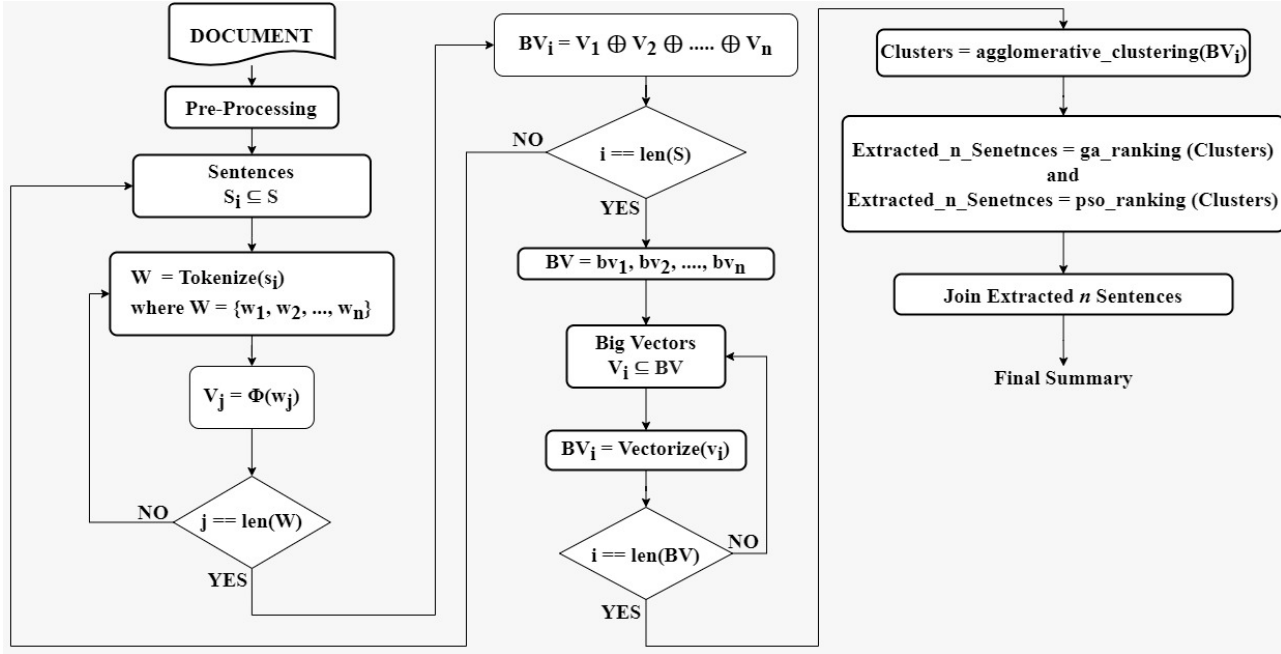
Figure 3. Flow diagram of proposed model.